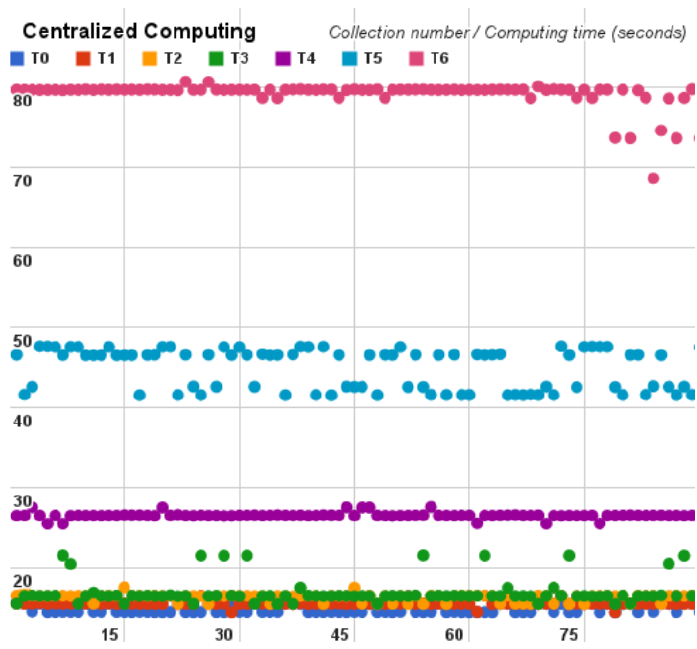
Figure 9. Centralized architecture as a dispersion variance.